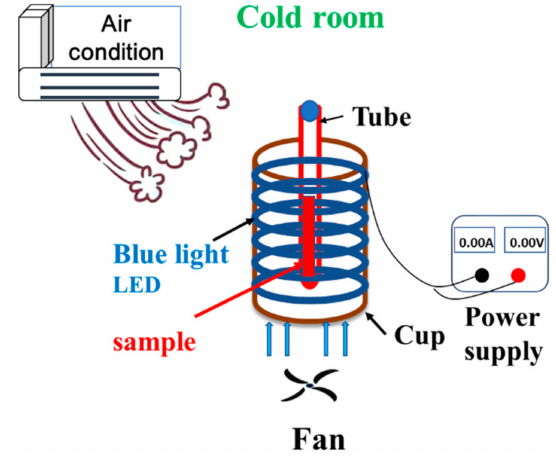
Figure 1. Organization of the photoreaction